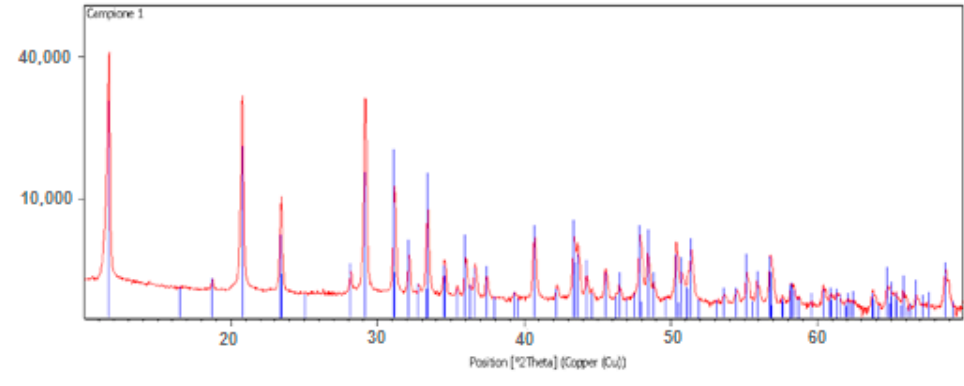
Figure 8. XRD analysis on solid precipitate.